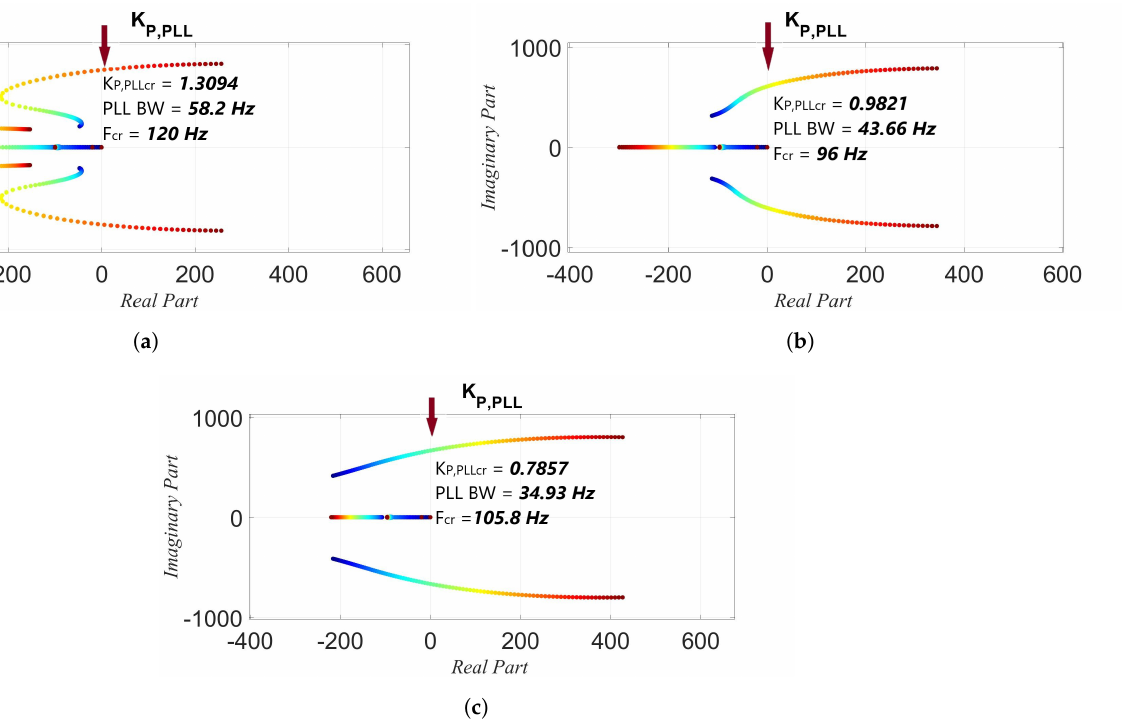
critical mode of instability is also shown.